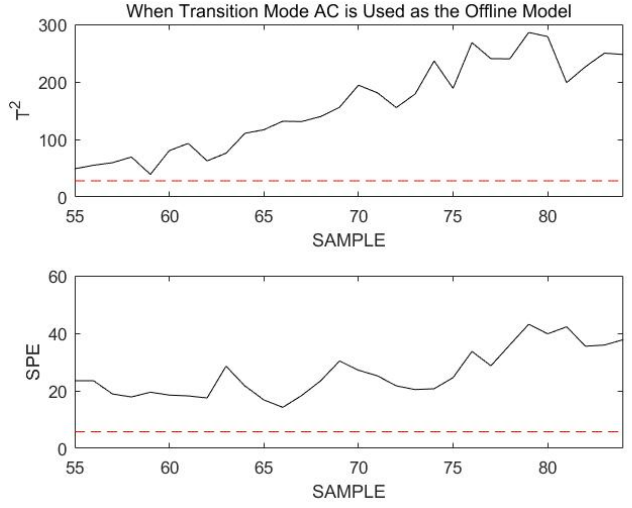
Figure 12. Monitoring 55th to 84th sample points using transition mode AC as an offline model.